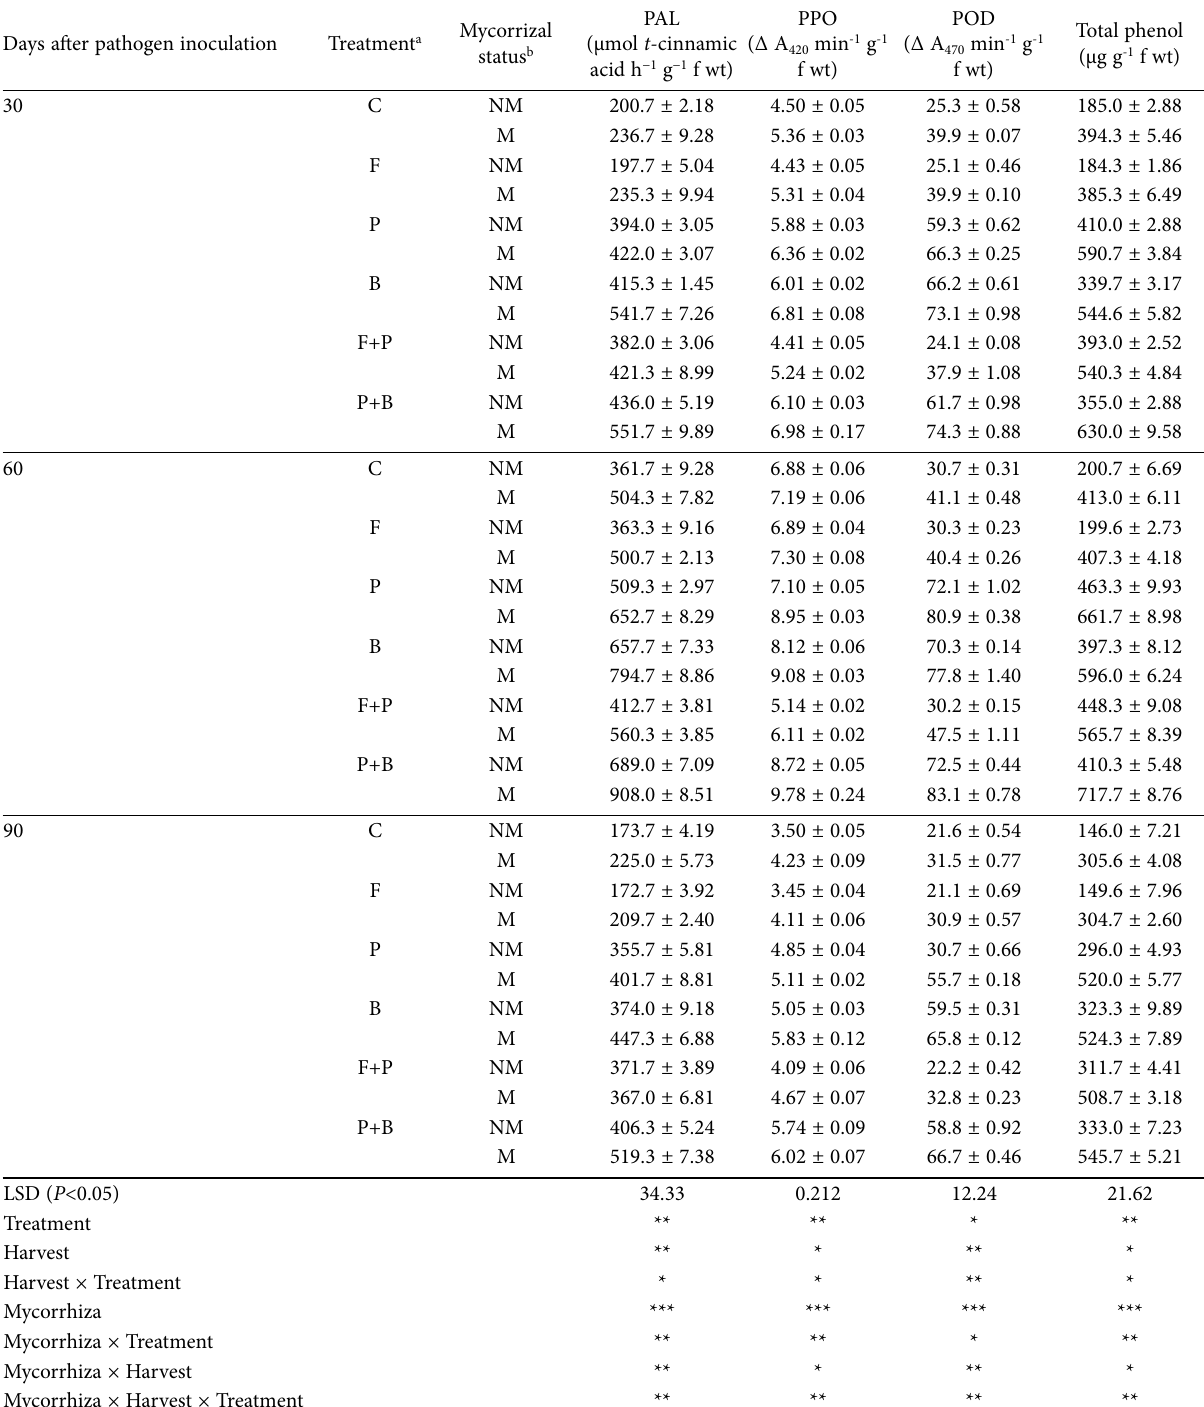
Table 7. Mean amounts (± standard error) of the defense-related enzymes phenylalanine ammonia-lyase (PAL), polyphenoloxidase (PPO) and peroxidase (POD), and total phenol in garlic plants receiving different treatments of Sclerotium cepivorum inoculation or AMF and/or B. amyloliquefaciens